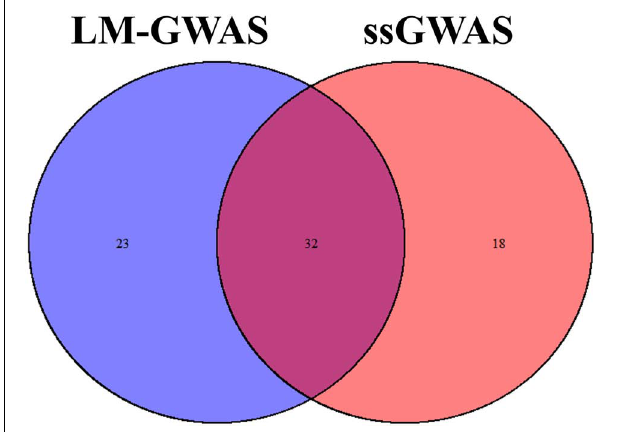
FIGURE 4 | Venn plot of significant SNPs in two methods. Significant SNPs by linear model GWAS (LM-GWAS) and single-step GWAS (ssGWAS) for four